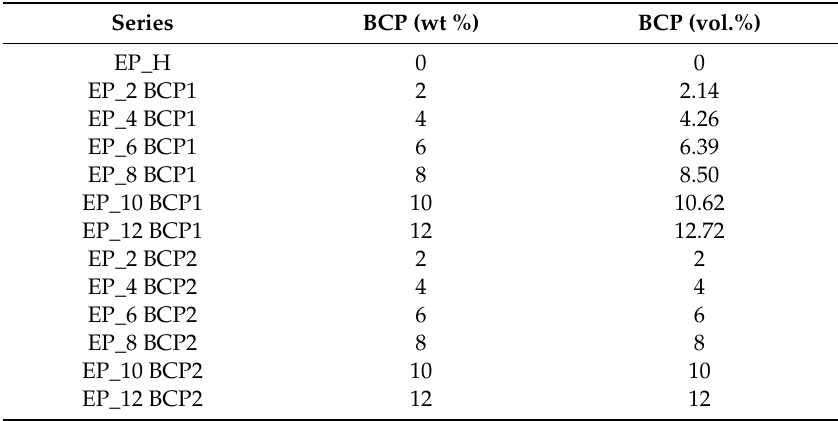
Table 1. Composition and nomenclature of bulk epoxy based